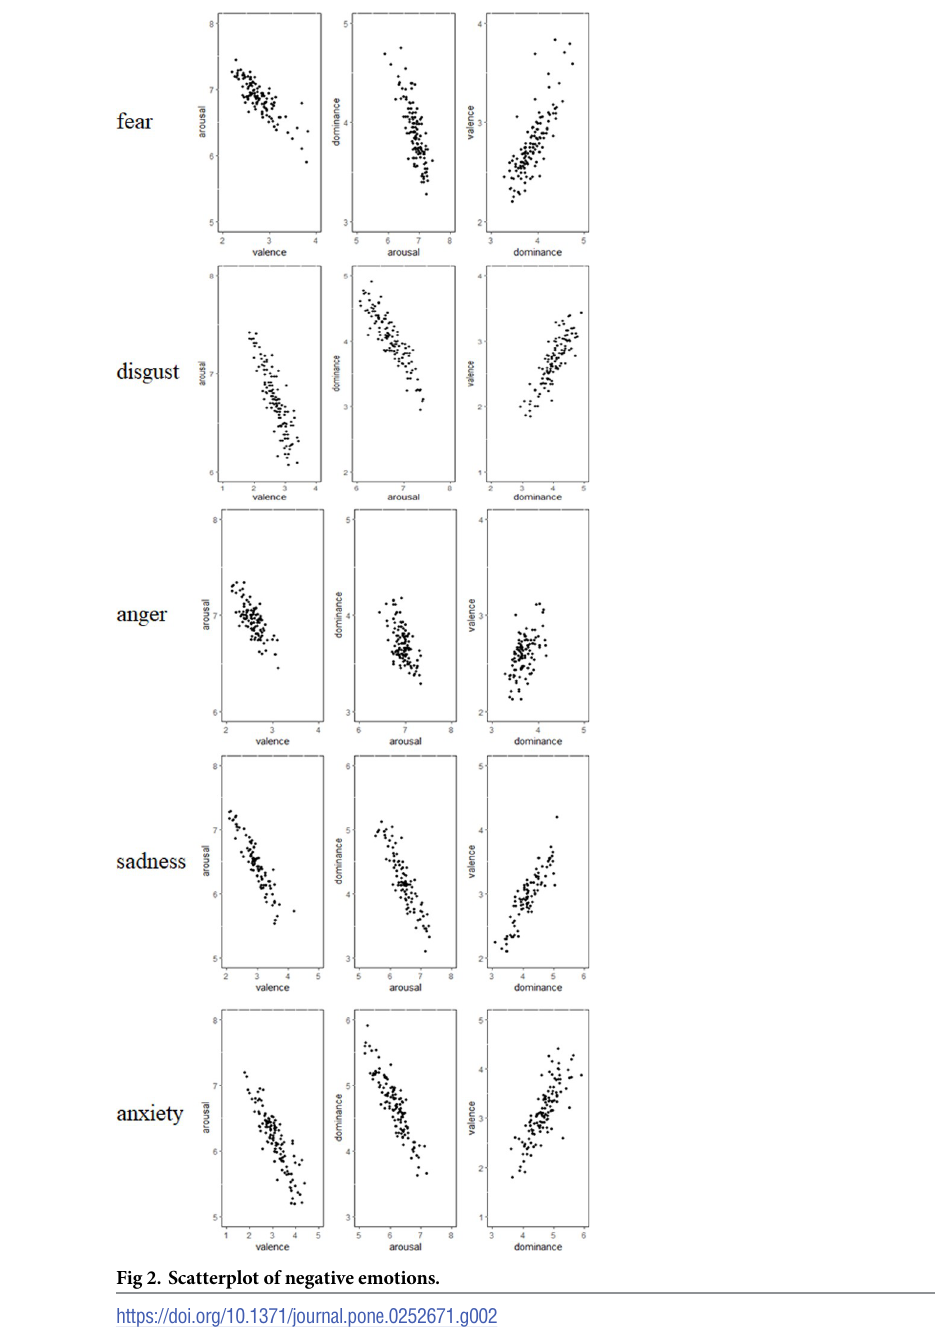
Thirty participants (14 men and 16 women) from Suzhou, aged 20.10 ± 1.32 ( M ± SD ) years were recruited through advertisements. The sample size was calculated by G � Power ( α = 0.05, β = 0.8), and the results showed that the sample size was standard and sufficient [25]. Partici- pants volunteered for this experiment and had not participated in Study 1. They signed